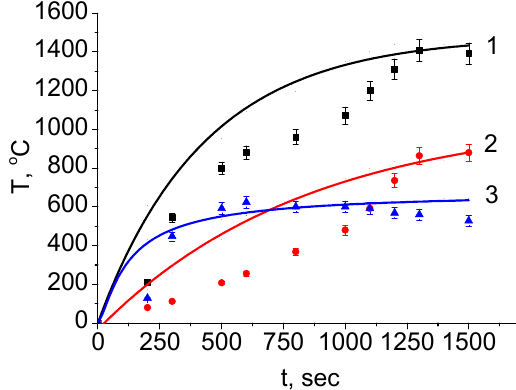
Figure 4. Comparison of calculated dependencies (lines) with experimental dependencies (dots): 1—irradiated side, 2—non-irradiated side, 3—difference in temperature between the sides. The irradiation power density is 165 W/cm 2 . Table 2. Sample elemental composition and thickness. Layer No.